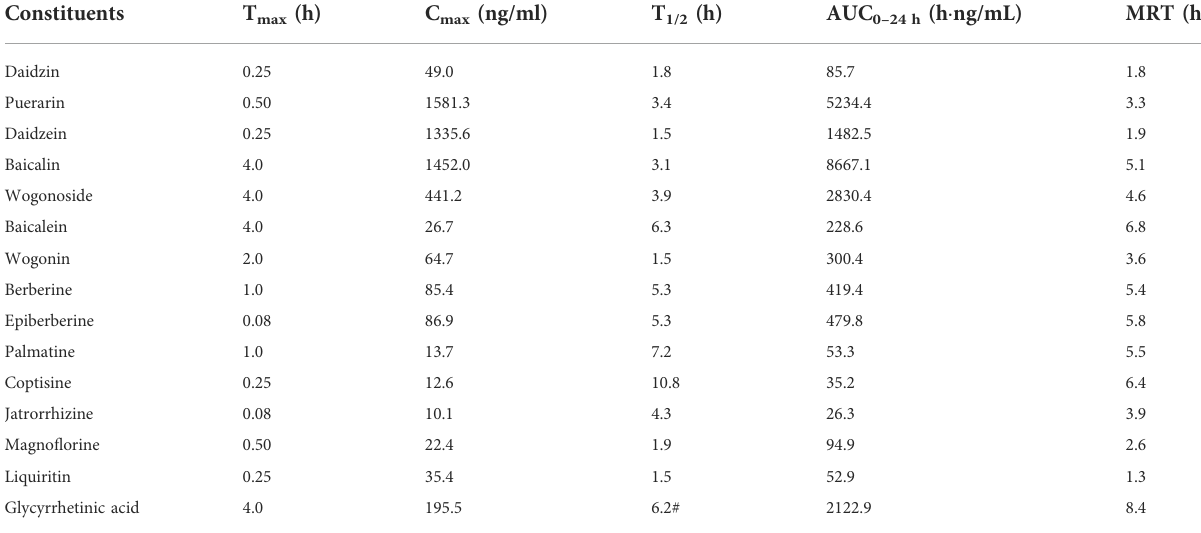
TABLE4Pharmacokineticparametersoftheconstituentsinthesystemiccirculationofthemicereceivedoral Gegen - Qinlian decoctionatthedosage of 6.1 g/kg (mean ± SD, n = 6).